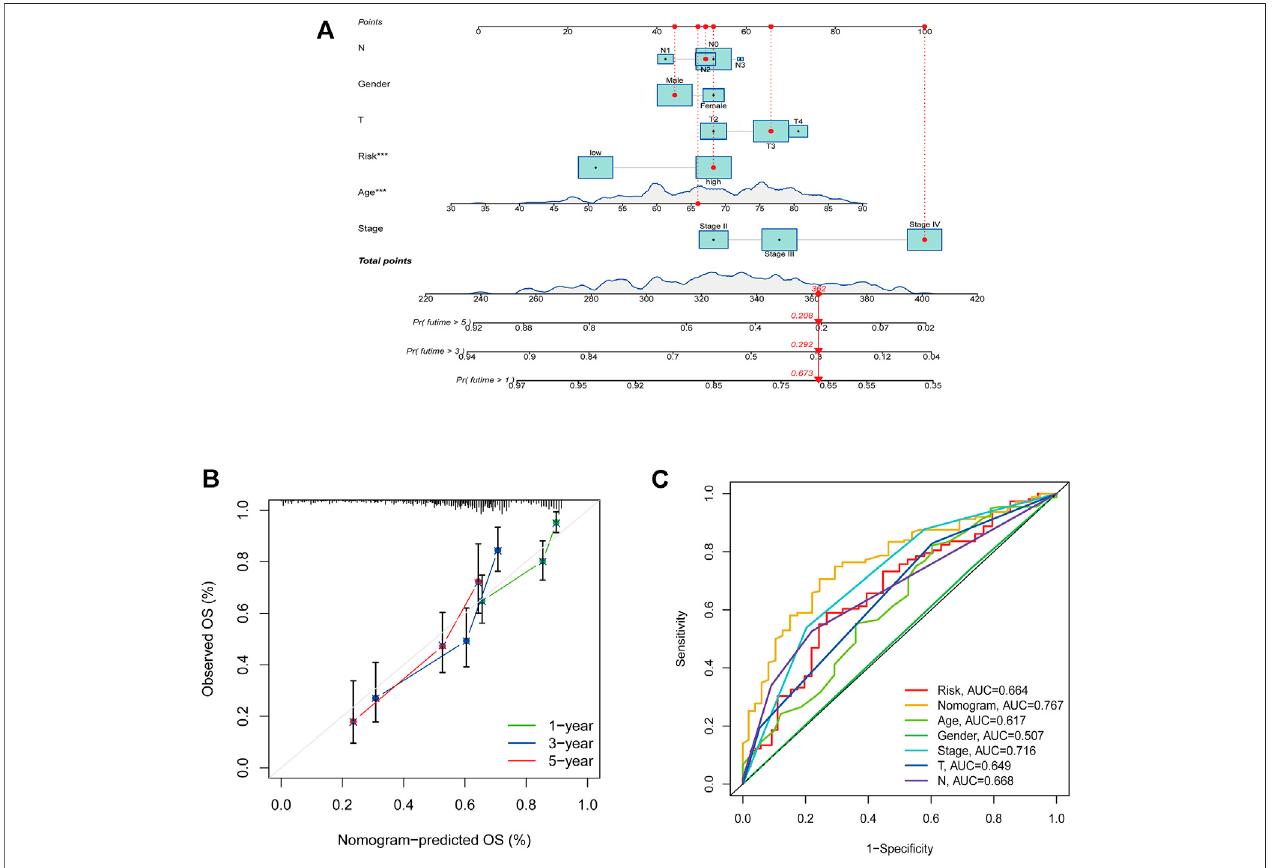
FIGURE 9 | Construction of the nomogram with risk score. (A) A nomogram to predict survival. (B) A calibration plot for prediction. (C) AUC for the nomogram.